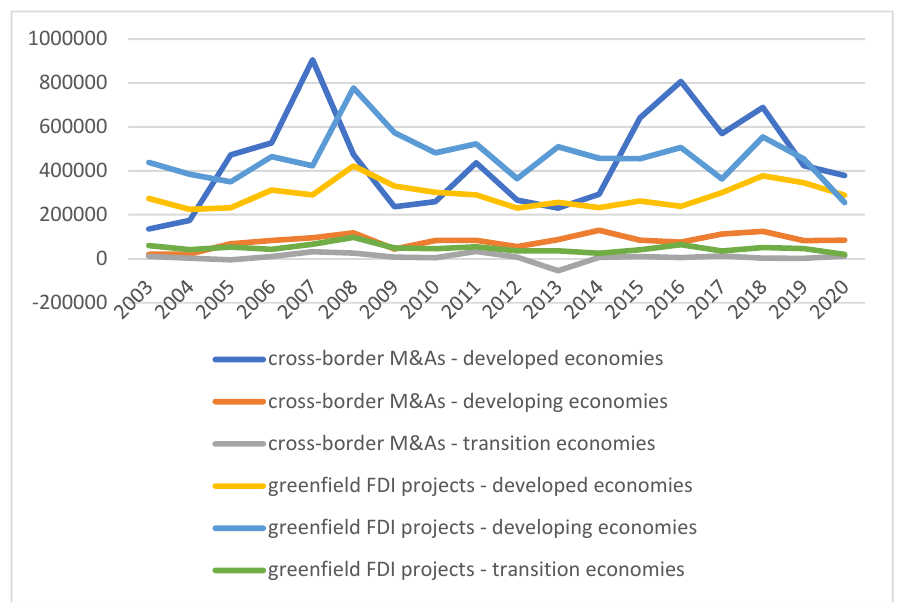
Figure 3. Development of values of cross-border M&As and greenfield projects in millions of USD (own processing based on data from [42]).